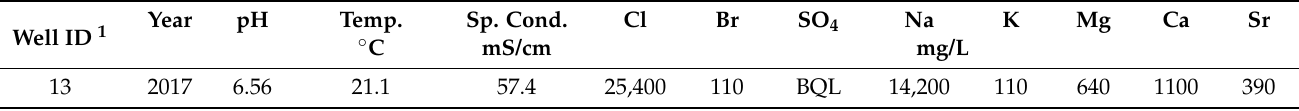
Table 2. Geochemical results from 2017